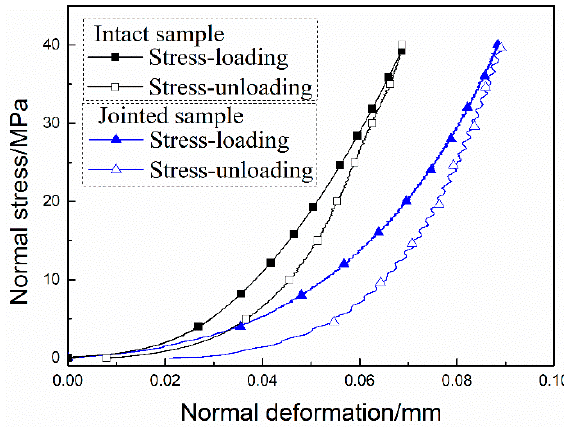
Figure 4. The curve of normal stress-normal deformation of intact and jointed sample under stress-loading and -unloading.